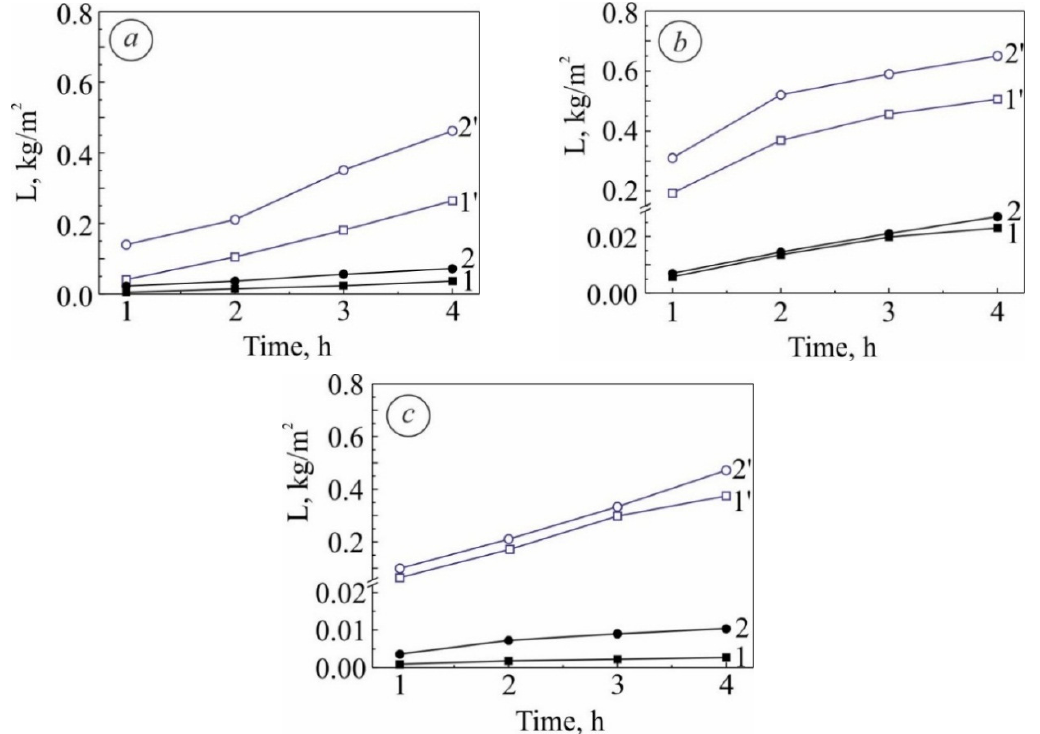
Figure 13. Cumulative wear mass loss for friction couples “AISI 304 steel (curves 1, 2)—counterbody (curves 1 / , 2 / )” at a contact pressure of 0.29 MPa (curves 1, 1 / ) and 0.42 MPa (curves 2, 2 / ) in the ( a ) initial state, and after laser alloying with a plaster of ( b ) 85Nb + 15% liquid glass, and ( c ) 15Fe + 30Ni + 20B + 10Si + 25% liquid glass.